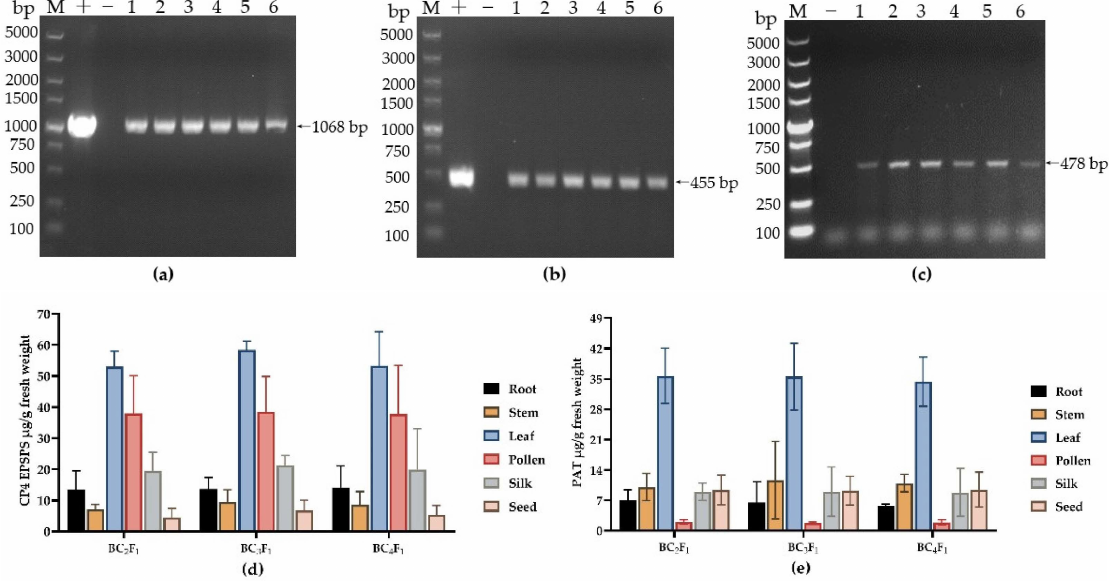
Figure 6. PCR analysis of transgenes in three generations of SCB-29. ( a ) PCR products for cp4 epsps in three generations of SCB-29. ( b ) PCR products for bar in three generations of SCB-29. ( c ) Event- specific PCR analysis of three generations of SCB-29. ( d ) Protein expression levels of CP4 EPSPS in different tissues of three generations of transgenic maize SCB-29. ( e ) Protein expression levels of Bar in different tissues of three generations of transgenic maize SCB-29. M, DL 5000 DNA Marker. +, plasmid DNA. − , non-transgenic maize. 1–2, BC 2 F 1 generation of transgenic maize SCB-29. 3–4, BC 3 F 1 generation of transgenic maize SCB-29. 5–6, BC 4 F 1 generation of transgenic maize